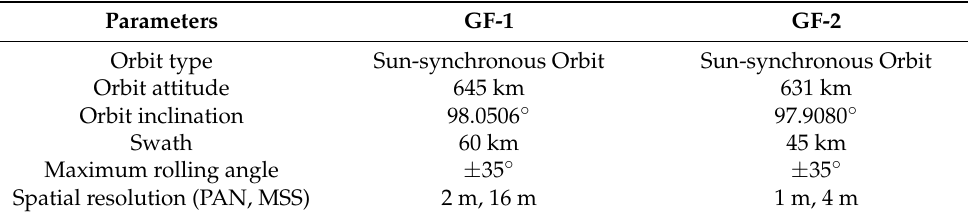
Table 3. Main parameters of and GF-1/2